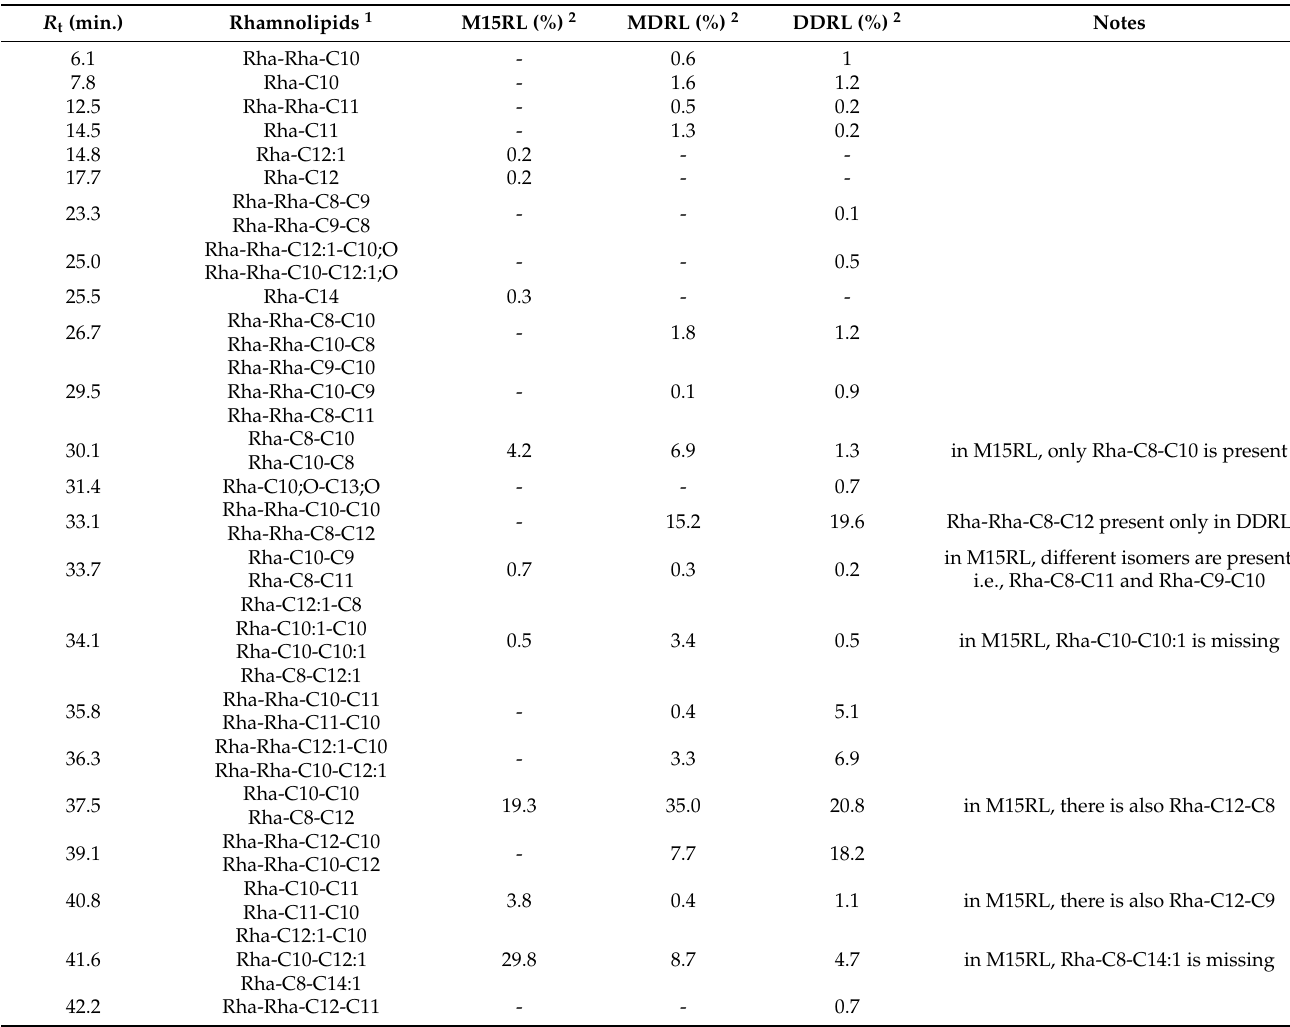
Table 1. Rhamnolipid composition of M15RL, MDRL, and DDRL mixtures. R t